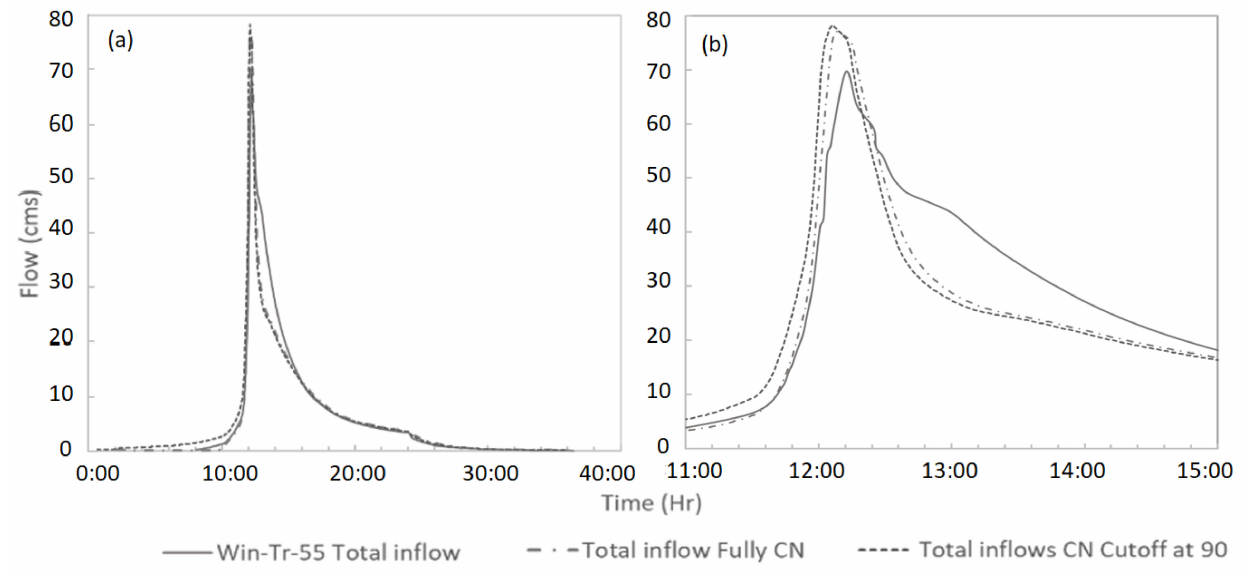
Figure 14. ( a ) Flow hydrograph for Moore’s Mill watershed yielded by WinTR-55 and two SWMM models of a Type III 24 h long, 5 yr return period rain. ( b ) Detailed view of the peak